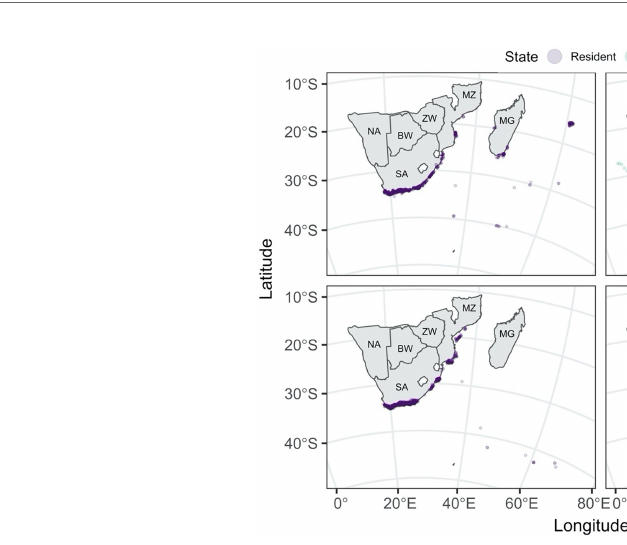
FIGURE 3 | Predicted shark locations coloured by Viterbi-decoded states. The tracks are separated by state (resident in purple: left column, transient in sea green: right column) and sex (females: top row, males: bottom row). Country codes are shown on the map: SA, South Africa; NA, Namibia; BW, Botswana; ZW, Zimbabwe; MZ, Mozambique; MG, Madagascar.